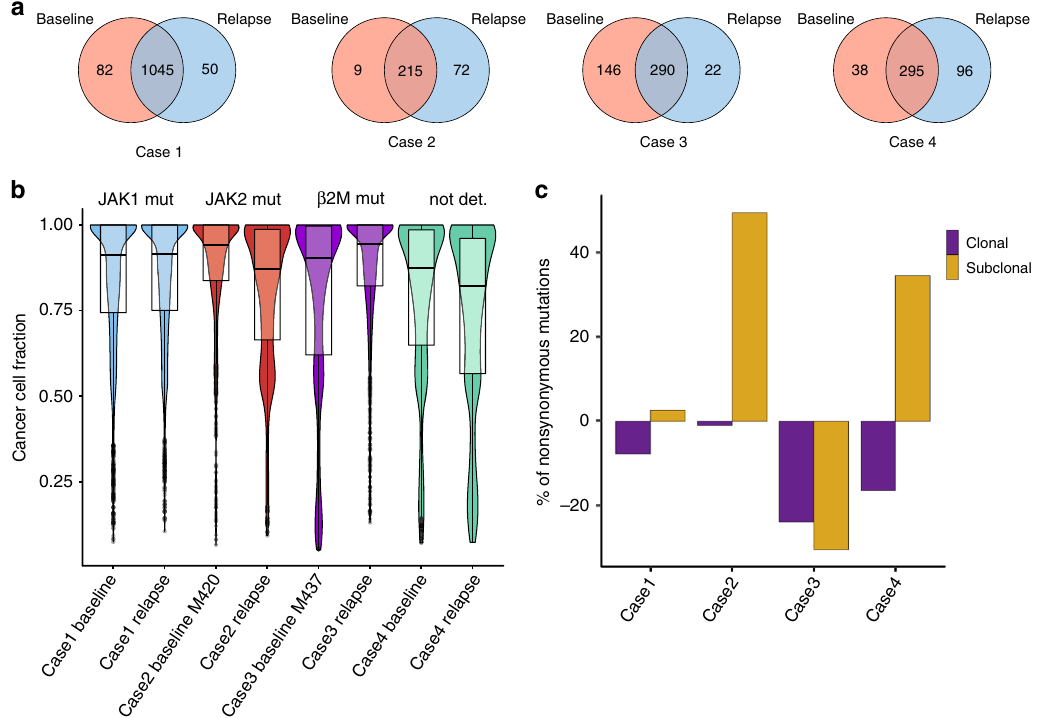
Fig. 5 Immunoediting and acquired resistance to PD-1 blockade in melanoma. a Number of mutations at onset of therapy and after relapse from a study by Zaretsky et al. 39 . b Violin plots showing tumor heterogeneity estimated from the cancer cell fractions. Box plots show the median, the 25th and 75th percentiles. c Relative variation in the number of nonsynonymous mutations detected in the relapse samples compared with the baseline in the study by Zaretsky et al.